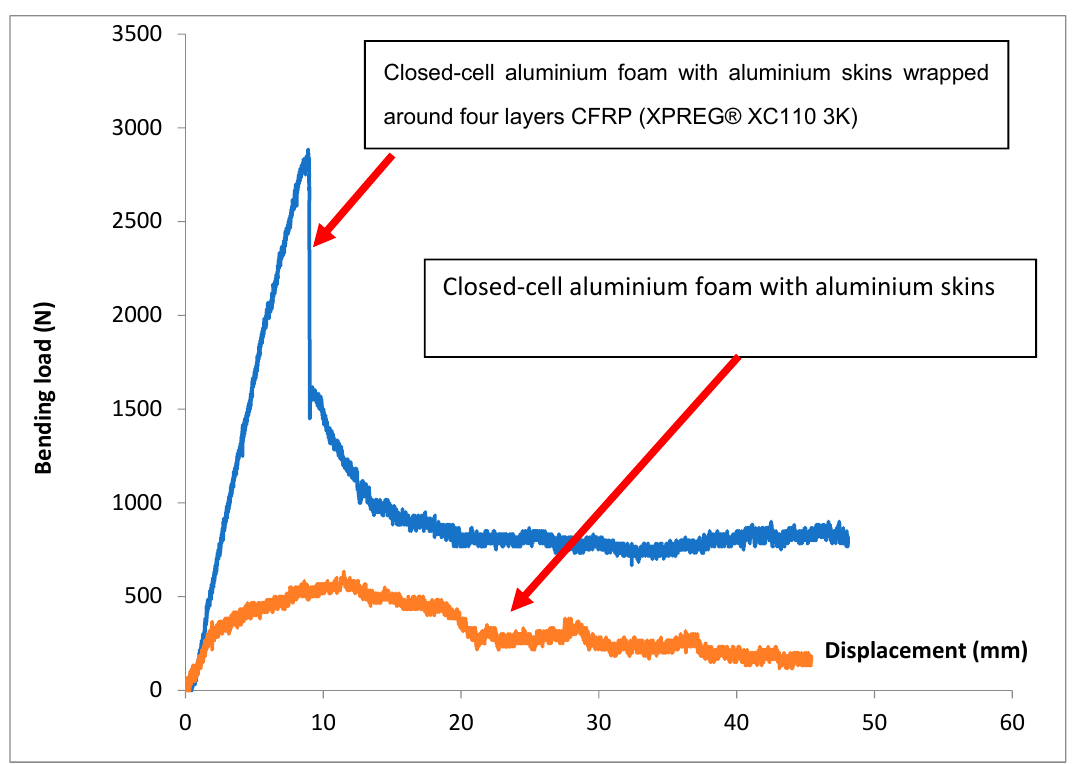
Figure 13. Comparison of the typically three-point bending tests results between closed-cell aluminium foam with aluminium skins and closed-cell aluminium foam with aluminium skins wrapped around four layers CFRP (XPREG ® XC110 3K). Table 7. The summary of the bending tests